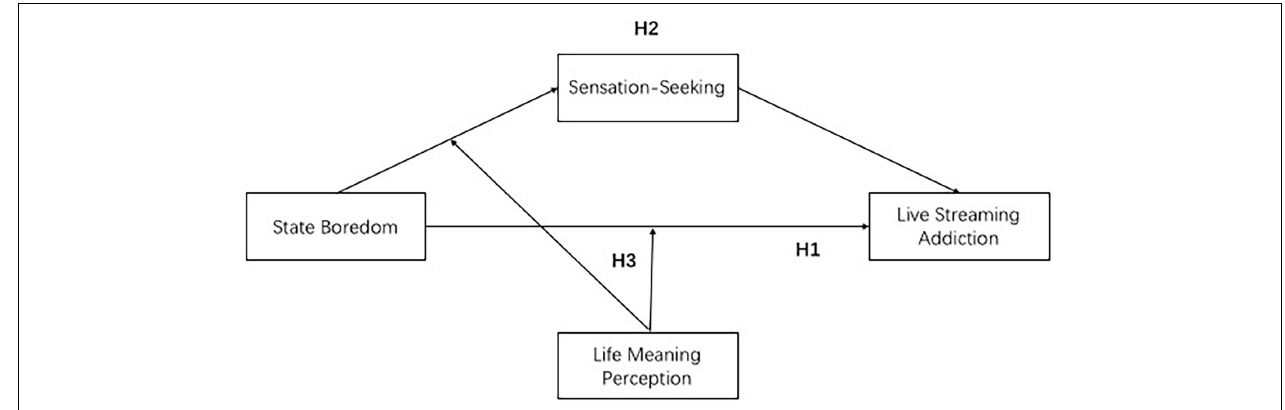
FIGURE 1 | Research framework.